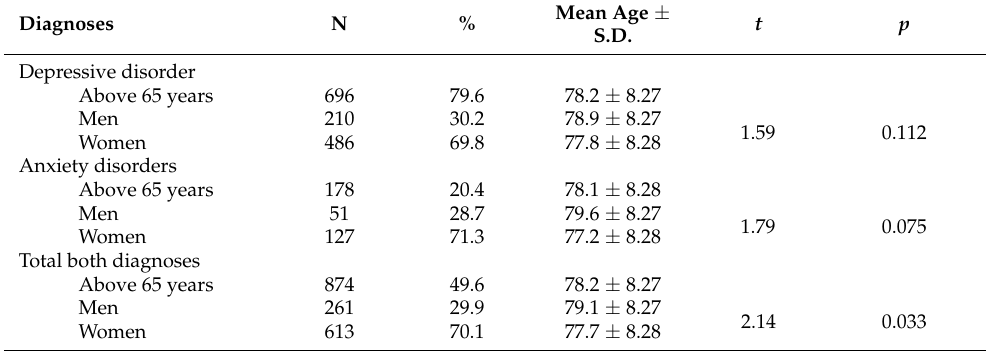
Table 4. Mean age and gender distribution of patients with depression/anxiety >65 years